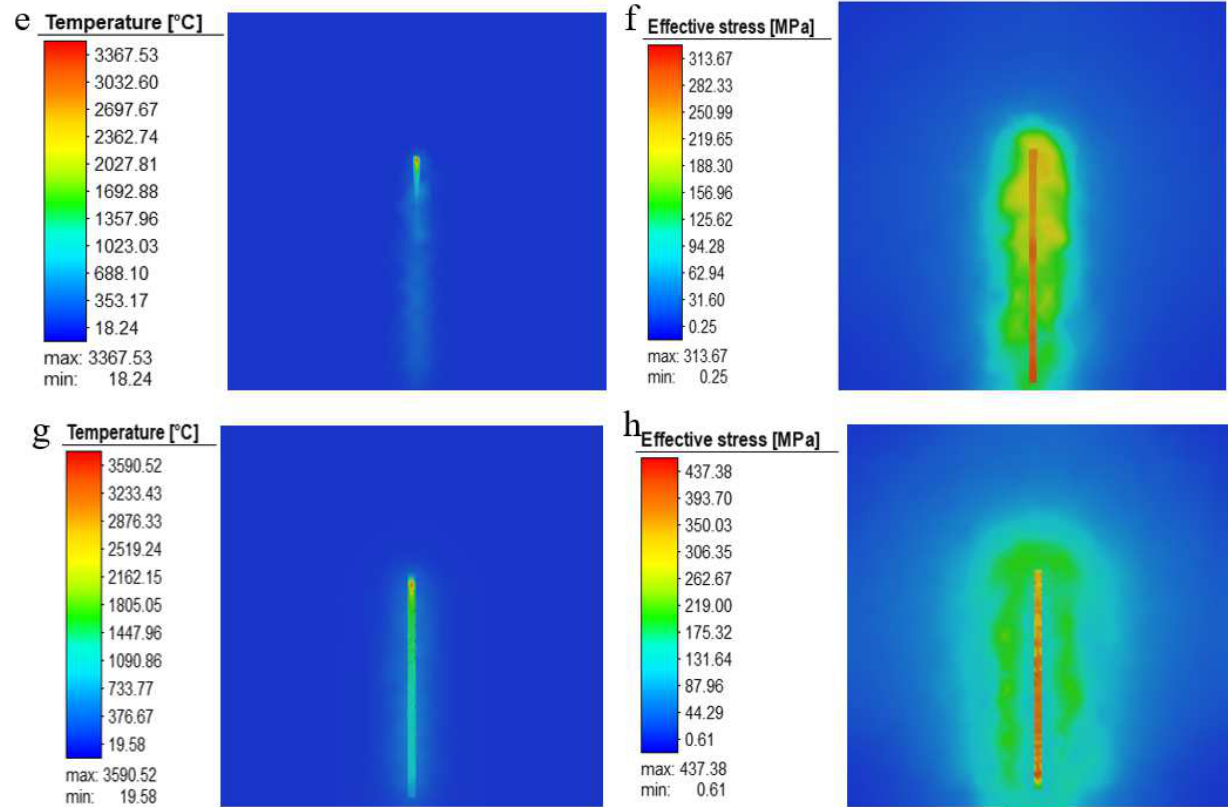
Figure 12. ( a ) Temperature field in layer 1 of experimental scheme 2, ( b ) stress field in layer 1 of experimental scheme 2, ( c ) temperature field in layer 10 of experimental scheme 2, ( d ) stress field in layer 10 of experimental scheme 2, ( e ) temperature field in layer 1 of experimental scheme 8, ( f ) stress field in layer 1 of experimental scheme 8, ( g ) temperature field in layer 10 of experimental scheme 8, and ( h ) stress field in layer 10 of experimental scheme 8.